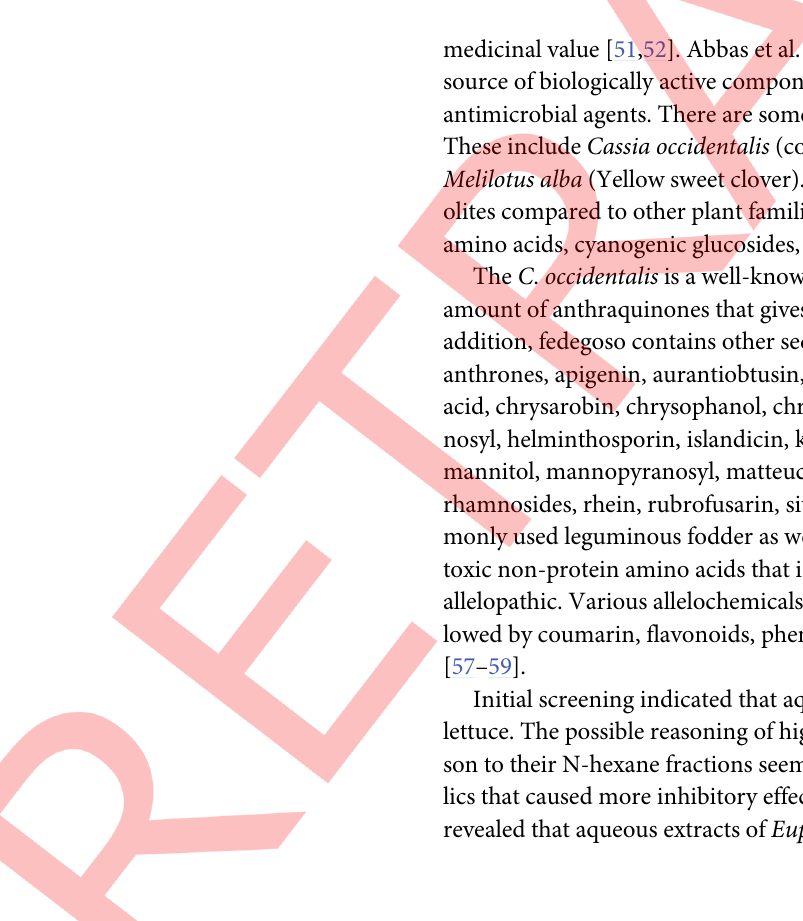
SOV = source of variation � = Significant, DF = degree of freedom, GP = germination percentage, T length, SL = shoot length, SV = seedling vigor index, DW = dry